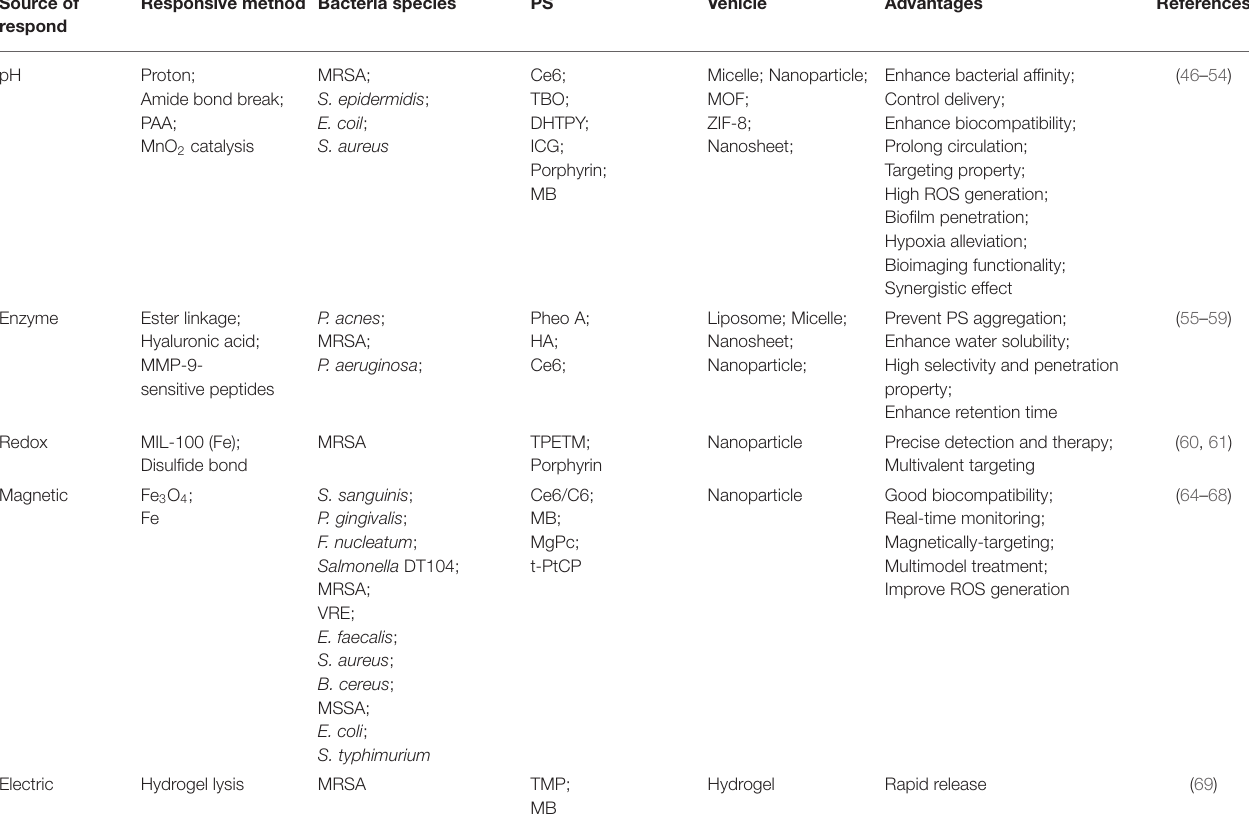
TABLE 1 | Summary of stimuli-responsive Nanoplatforms-Assisted PDT in anti-bacterial. Source of